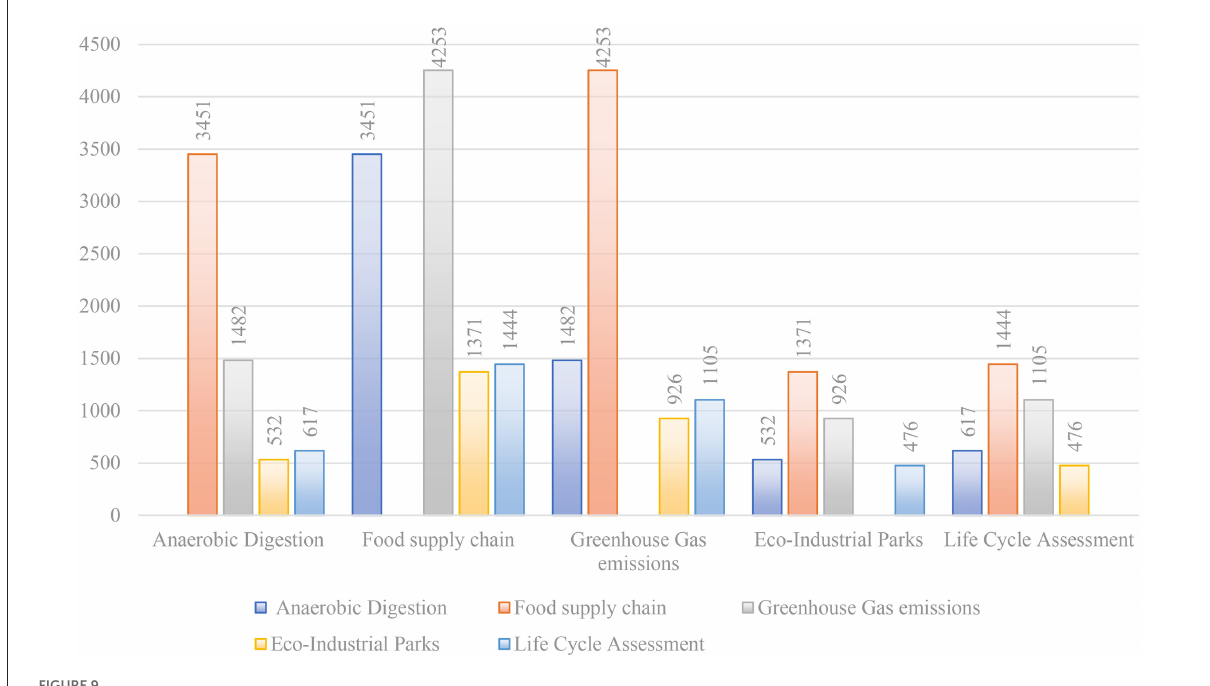
FIGURE9 Co-occurrence network for clusters. Source: our elaboration using